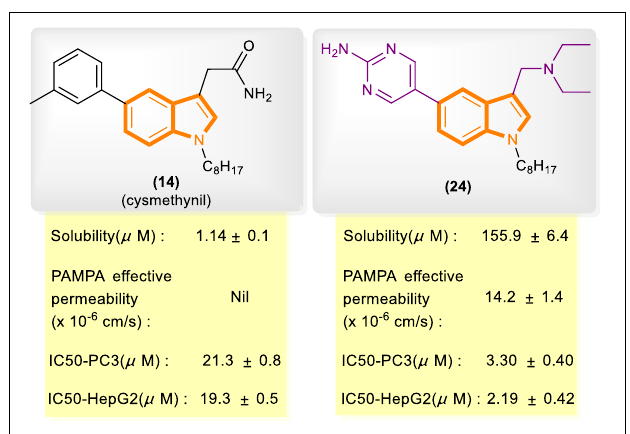
FIGURE 5 | Comparison of some aspects of cysmethynil and